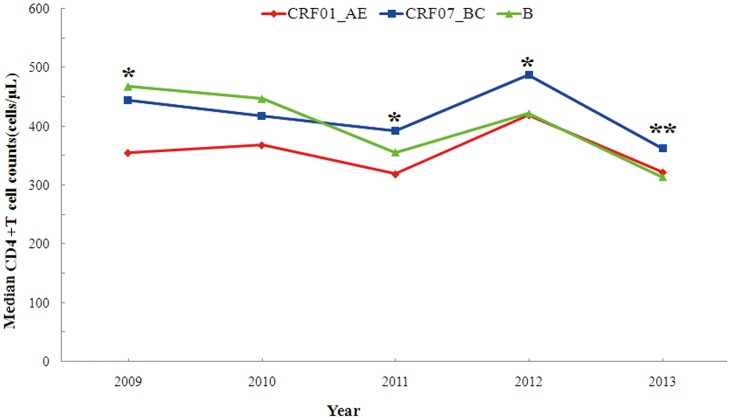
Association of three different subtype strains circulating among HIV-1-infected MSM from 2009 to 2013 with baseline CD4+T cell counts.*: P<0.05 when comparing CRF01_AE with CRF07_BC; **: P<0.01 when comparing CRF01_AE with CRF07_BC.